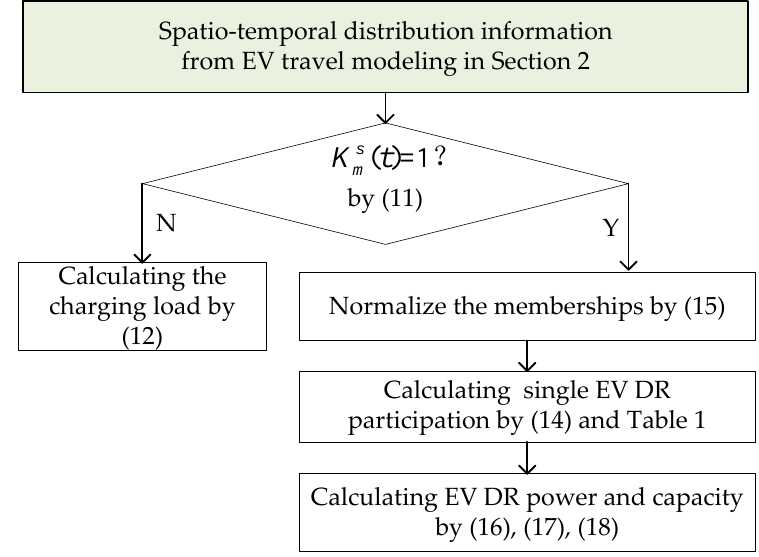
Figure 5. Flowchart of EVA-DRE method.